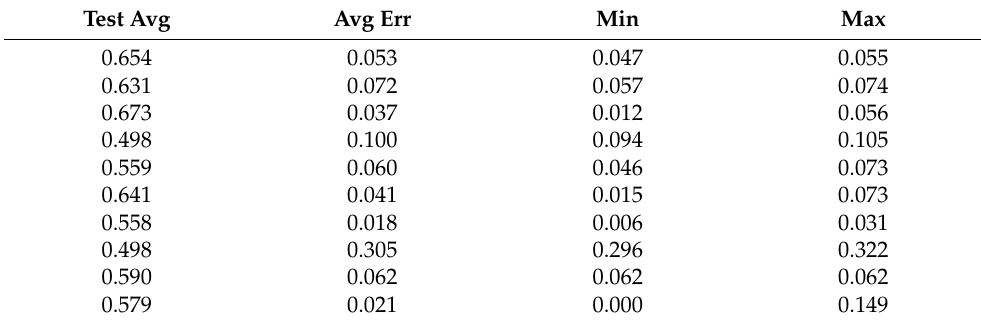
Table A117. Set 2, trials 21–30 data (average actual PR values).